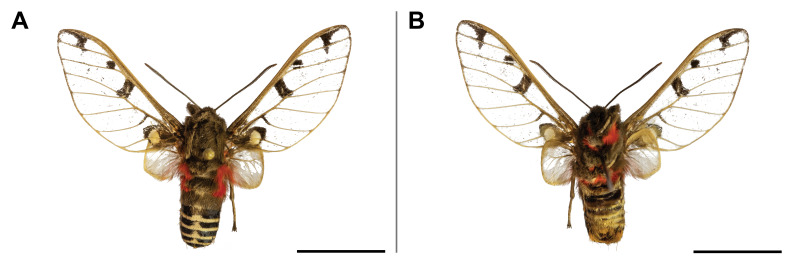
Balacra
compsa (Jordan, 1904). A. dorsal view; B. ventral view. The scale bar represents 1 cm.